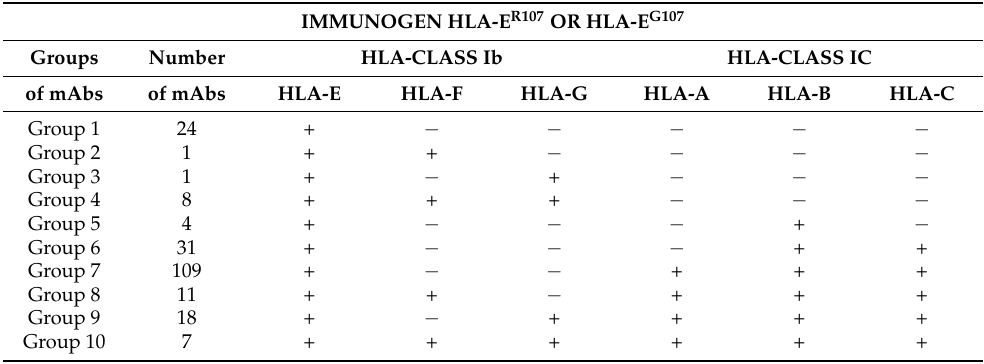
Table 3. The HLA-1 signatures of the mAbs generated after immunizing recombinant heavy chains of HLA-E. Group 10 is truly befitting the definition of a polyreactive mAb